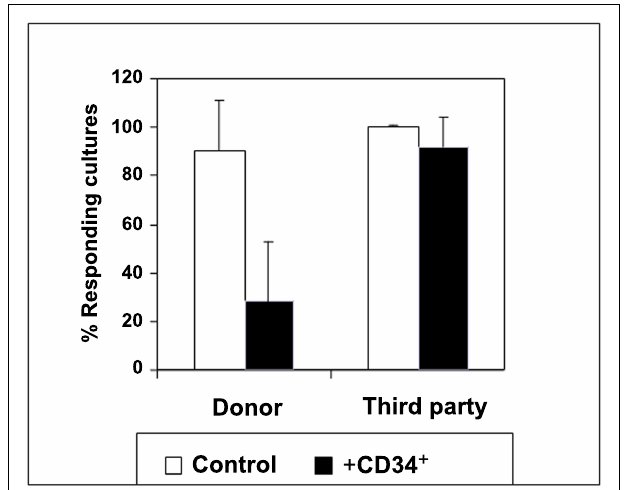
FIGURE 1 |The regulatory activity of CD34 cells: evidence for target specificity. The average CTL response (SD) in the presence (black bars) or absence (white bars) of CD34 + cells at a veto-to-responder cell ratio of 0.5.The veto effect was tested by a limiting dilution assay as follows: Equal numbers (1 × 10 6 /ml) of responder cells and irradiated allogeneic stimulator cells from the donor of the CD34 cells and a third-party donor were co-cultured for 5 days.The responder cells were then cultured again for 7 days under limiting dilution, and the CTL activity was determined by 51 Cr-release assay. Data represent the average ± SD of 11 independent experiments using different donor and third-party pairs. A significant difference ( p < 0.001 on t -test compared with control cultures without CD34 cells) between control cultures and those including CD34 cells was found upon stimulation against donor cells (Rachamim etal.,